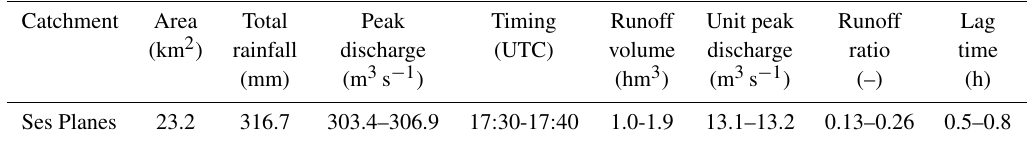
Table 3. Range of the main hydro-meteorological features estimated from the hydrological simulations for the 9 October 2018 flash flood episode at the entrance of Sant Llorenç town. Note that lag time has been computed as the time difference between the net rainfall and runoff